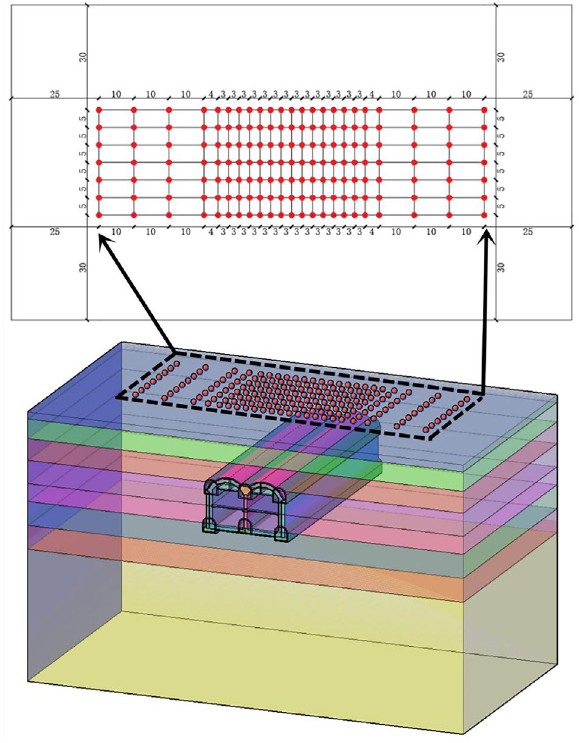
Figure 9. Schematic of surface monitoring site arrangement.